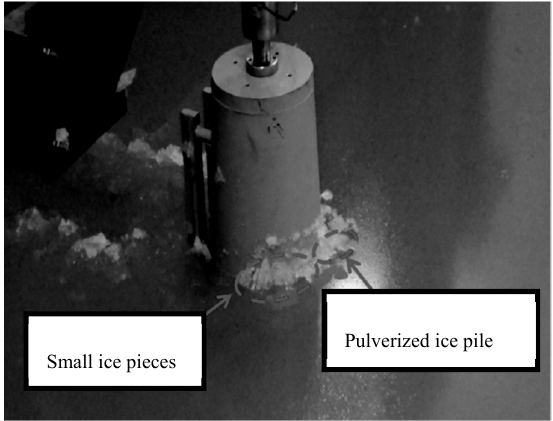
Figure 15. Experimental scenarios of non-simultaneous ice crushing at a mean waterline for test 306.